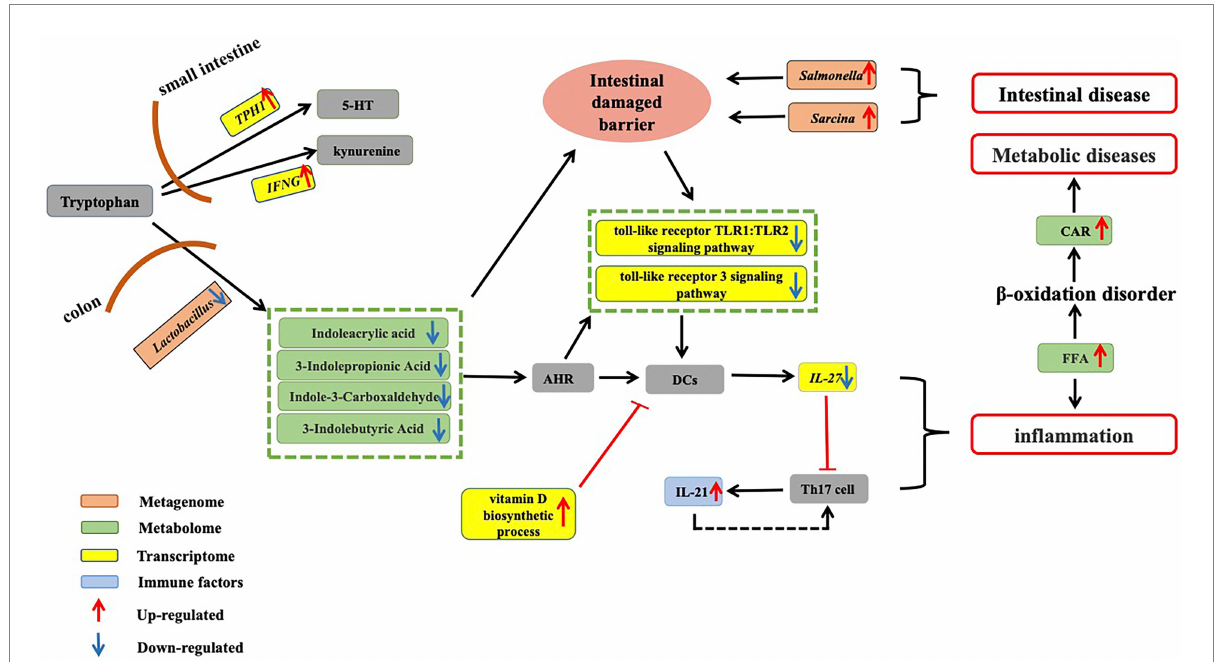
FIGURE 5 Dysregulation of tryptophan metabolism in aged CRs. Tryptophan obtained from food is absorbed in the small intestine. Up-regulation of key gene TPH1 , which is involved in 5-HT synthesis, and up-regulation of IFN- γ , which is involved in the conversion of tryptophan into kynurenine, suggest a decrease in circulating tryptophan in aged CRs. On the other hand, in the colon, tryptophan is metabolized by gut microbiota to produce indole- 3-carboxaldehyde, 3-indolepropionic acid, and indoleacrylic acid. Our results showed that Lactobacillus abundance decreased in old CRs, leading to a decrease in AhR ligands in the plasma. Down-regulation of the Toll-like receptor TLR1:TLR2 and Toll-like receptor 3 signaling pathways and up-regulation of vitamin D biosynthetic process pathway suggested that activity of DCs decreased, which may lead to a decrease in IL-27 expression and an increase in IL-21 expression. The decrease in microbial tryptophan metabolites may affect intestinal mucosal barrier integrity, allowing gut pathogens (such as Salmonella and Sarcina ) to invade the host. Thus, these changes can induce the occurrence of inflammation and various gut diseases. Increased FFAs can lead to inflammation and accumulation of CARs, which may induce various metabolic diseases in aged CRs. CRs: Chinese rhesus macaques; AhR: Aryl hydrocarbon receptor; DCs: Dendritic cells; FFA: Free fatty acids; CAR: Acyl